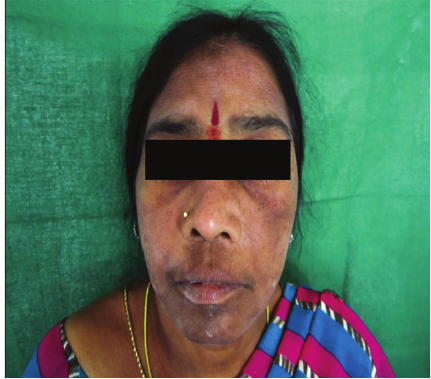
Figure 1: Extraoral examination reveals swelling in the left side of the face just below the eye.